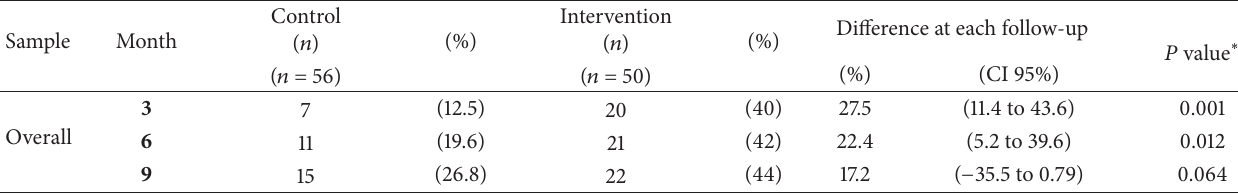
Table 2: Remission of depression in the overall sample.